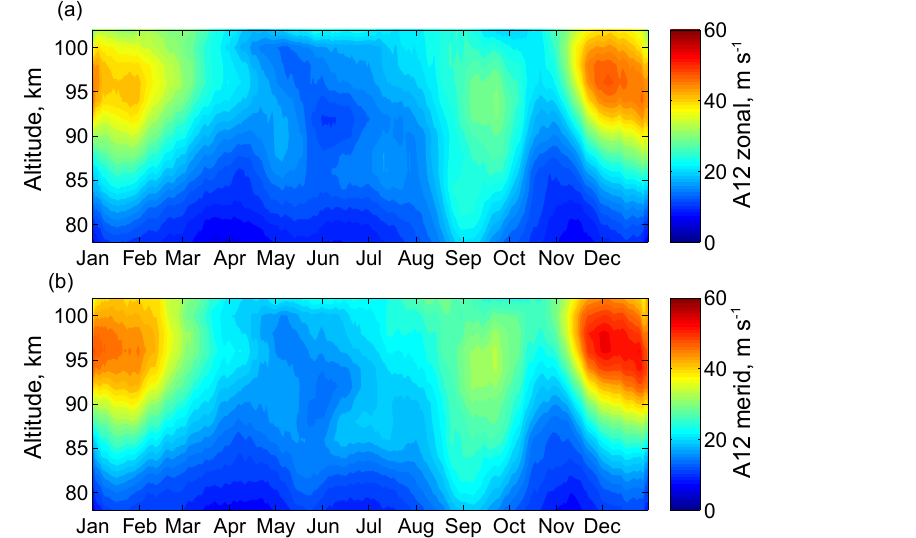
Figure 2. Amplitudes of semidiurnal tides at middle latitudes extracted from meteor radar observations over Juliusruh. Panels (a, b) corre- spond, respectively, to the zonal and meridional